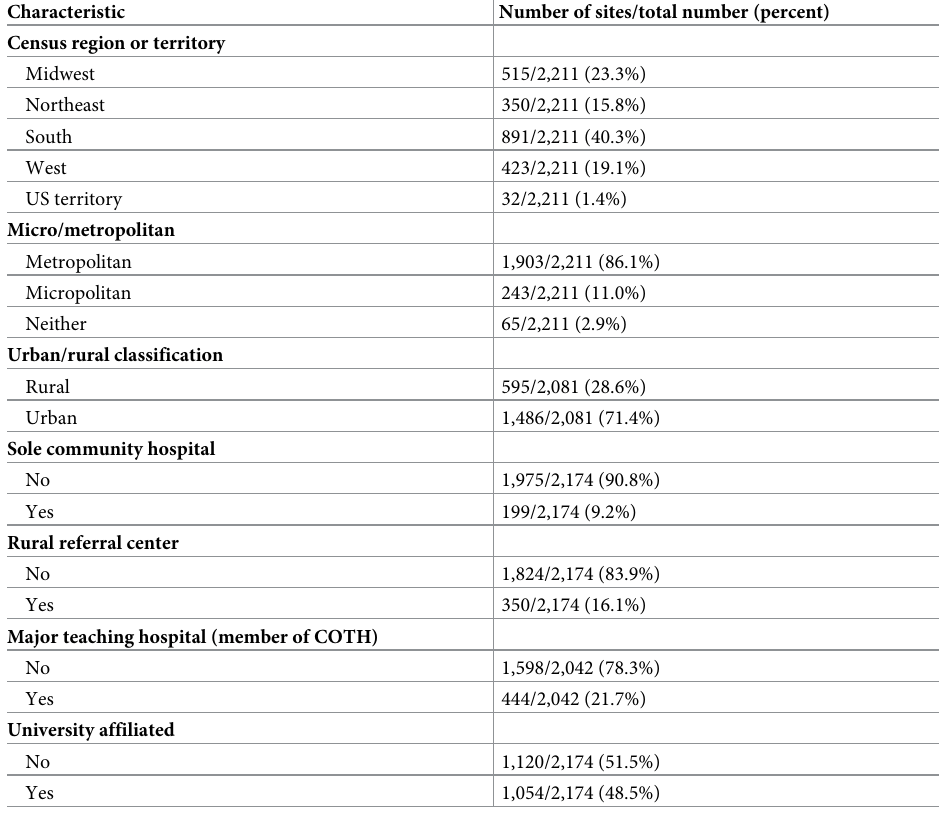
Table 3. Characteristics of sites that enrolled patients in the US Expanded Access Program (EAP) for convalescent plasma AU : InTable 3 : IchangedtheheadingforthesecondcolumnfromOveralltoNumberofsites = totalnumber ð percent Þ : Ifthisisnotcorrect ; pleaseeditasnecessary :